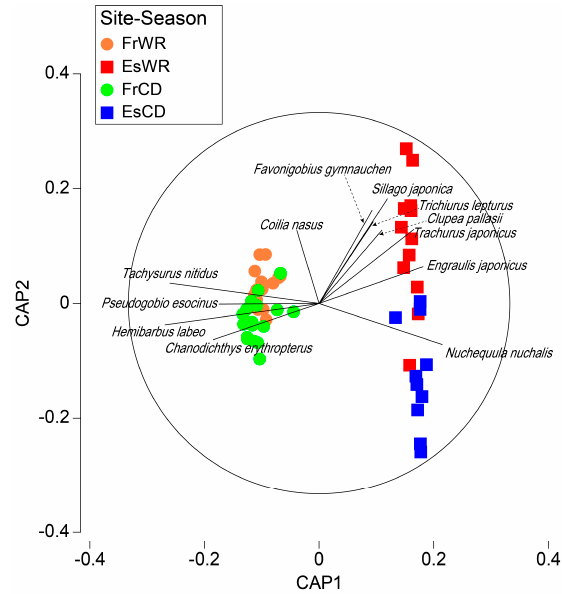
Figure 7. Ordination plots for canonical analysis of principal coordinates of fish assemblage site– season interactions in the lower Nakdong River, South Korea; Fr = Freshwater, Es = Estuary; WR = warm-rainy season, CD = cold-dry season.